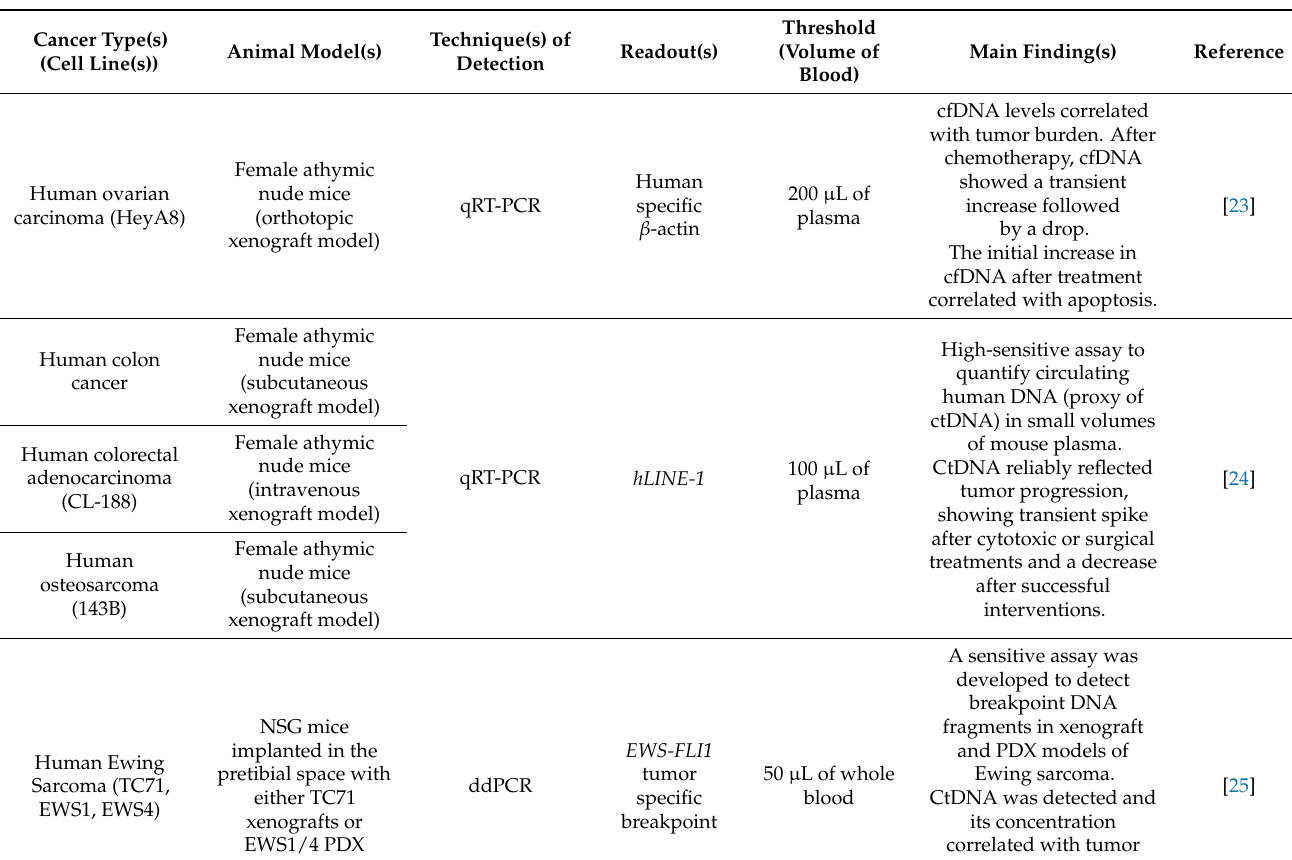
Table 1. Summary of studies investigating ctDNA in basic